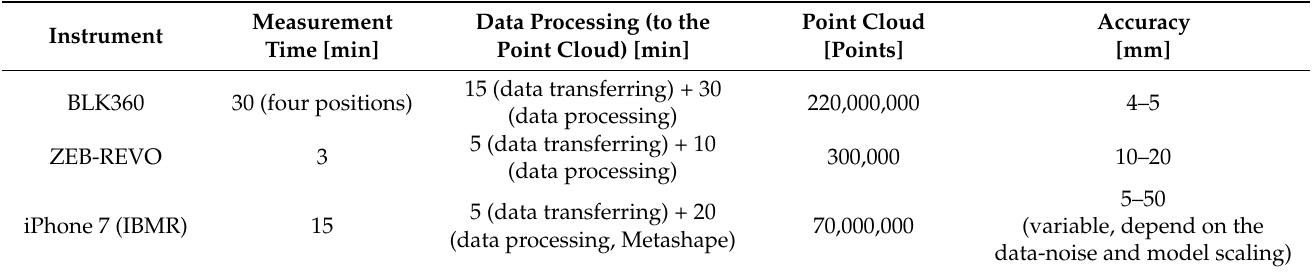
Figure 14. Ground schemes from ZEB-REVO ( a ), BLK360 ( b ), and iPhone ( c ); you can see that with the handheld scanner, the spaces behind the wall (behind the tip of the triangle) can also be documented. The model from photos, taken by an iPhone 7, was not very good due to bad lighting, inappropriate texture, combined with a short time for taking photos; however it is not a typical result from close-range photogrammetry, that can create high-quality 3D models..